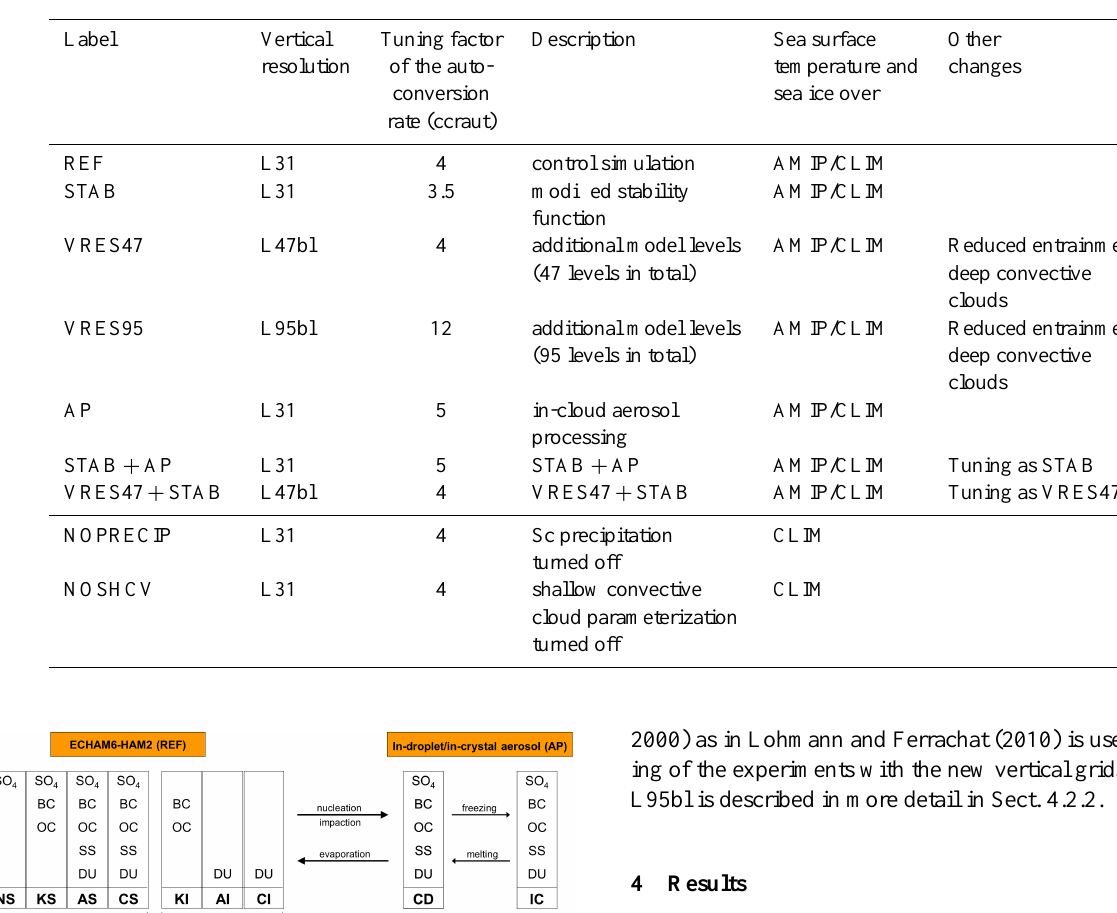
Table 1. Description of experiments conducted in this study.